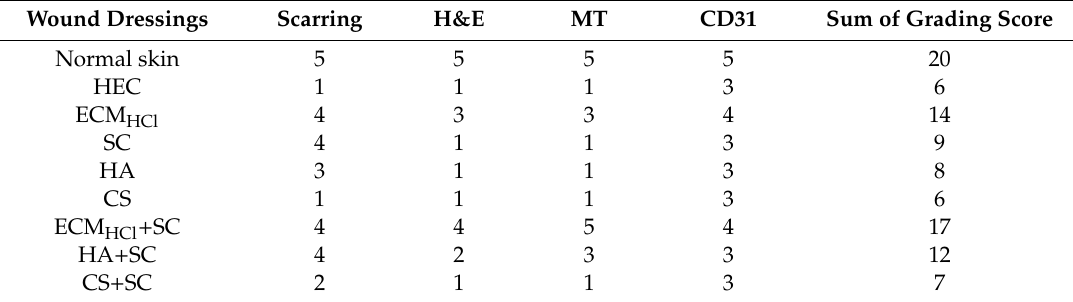
Figure 8. Rheological analysis of a ECM HCl,25 / SC wound dressing at ( A ) 25 and ( B ) 37 ◦ C. SEM images of a ECM HCl,25 / SC sponge on the surface ( C ) and the cross-section ( D ) (scale bar: 200 µ m). Table 4. Overall assessment for in vivo wound healing studies on day 14.